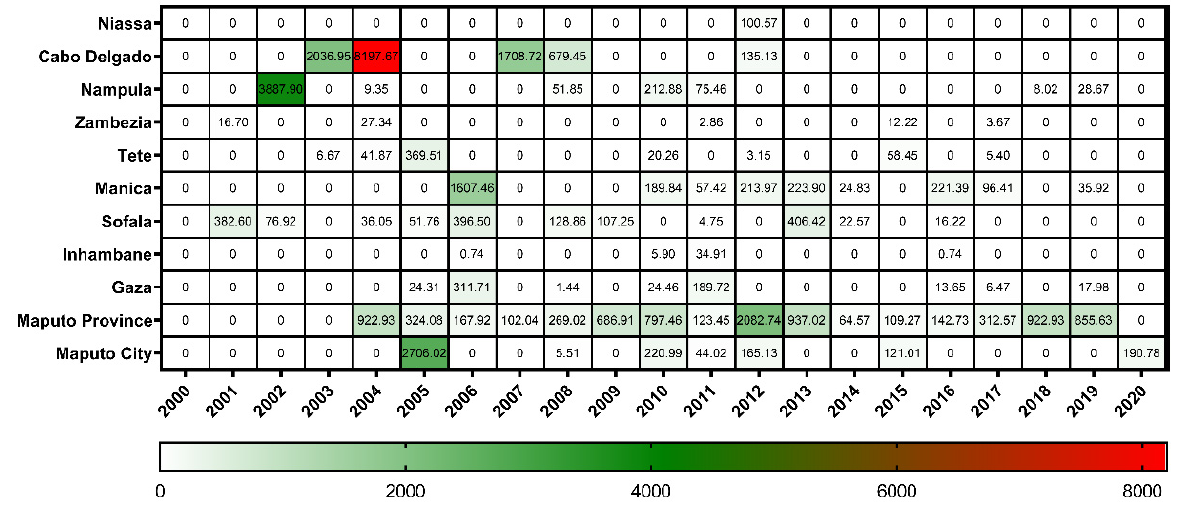
Figure 4. Total incidence risk (IR/100,000 animals) of African swine fever in pig population according to the analysis year and Mozambique provinces between 2000 and 2020.